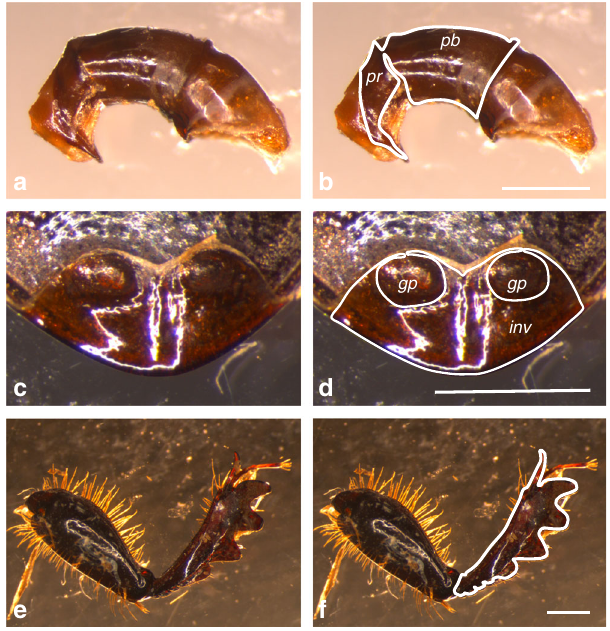
Fig. 1 Shape analysis. An example of the application of outlines to the proximal phalobase and distal parameres of the aedeagus ( a , b ), the pygidium ( c , d ) and the foretibia ( e , f ) of Onthophagus capella . Scale bar = 1 mm. pr parameres (note the sclerotization of the parameres relative the rest of the distal aedeagus segment), pb phalobase, gp genital pit, inv internal invagination of the